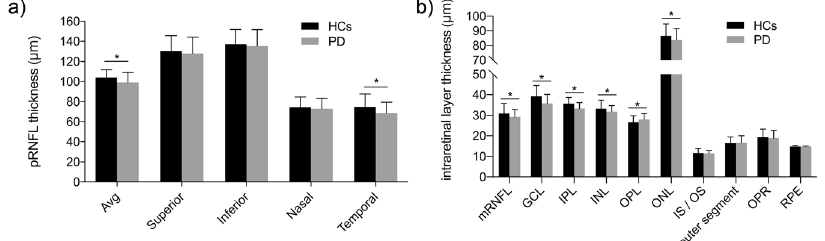
Fig. 2 Comparison of the retinal parameters between the Parkinson ’ s disease (PD) and healthy controls groups. a The average and temporal quadrant pRNFL thicknesses were signi fi cantly lower in the PD group than in the HCs group. b Patients with PD had a thicker OPL and thinner mRNFL, GCL, IPL, INL, and ONL. The error bars the indicate standard deviation of PD or HCs. HCs healthy controls, PD Parkinson ’ s disease, pRNFL peripapillary retinal nerve fi ber layer, mRNFL macular retinal nerve fi ber layer, GCL ganglion cell layer, IPL inner plexiform layer, INL inner nuclear layer, OPL outer plexiform layer, ONL outer nuclear layer, IS/OS inner segment/outer segment, OPR photoreceptor outer segment/retinal pigment epithelium, RPE retinal pigment epithelium.